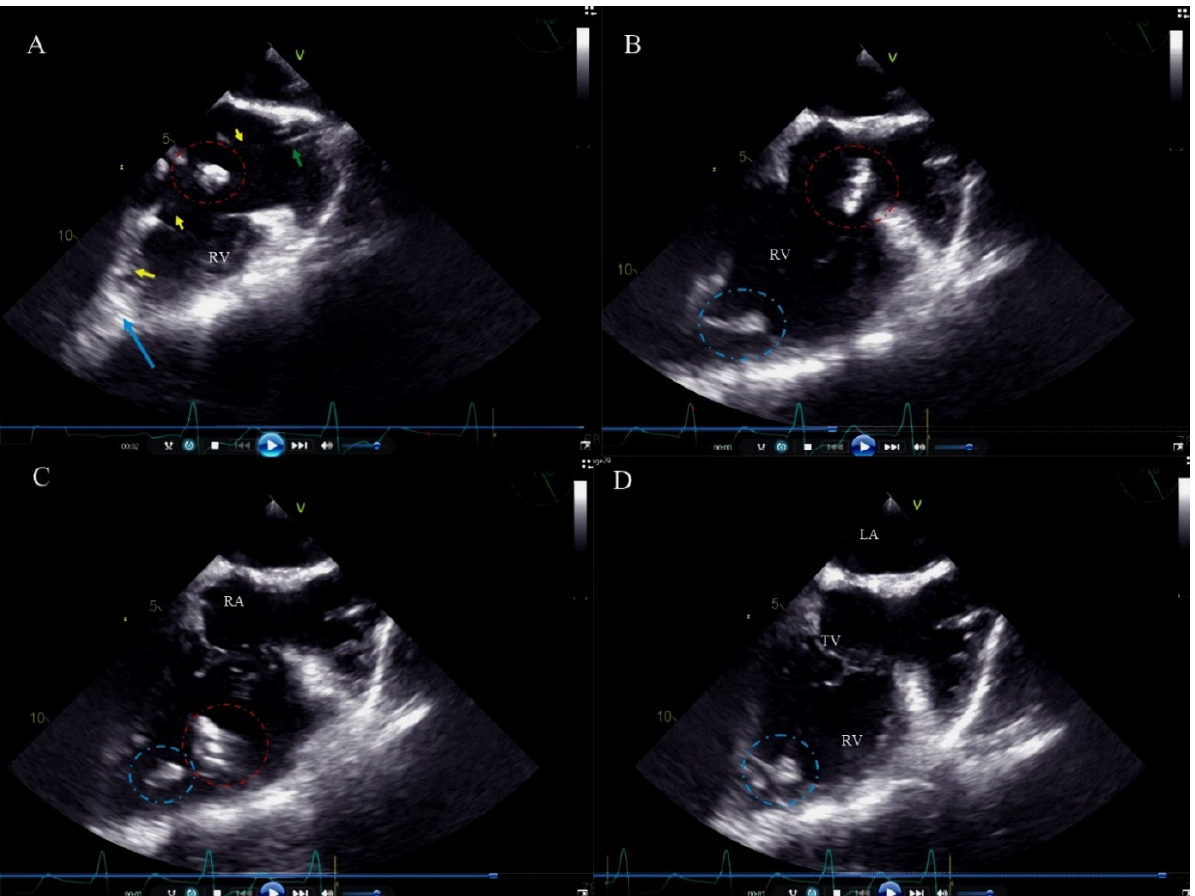
Figure 3. Concomitant occurrence of FG and SG and their fate imaged by 2D TEE (the sequences of the video and the behavior of the ghosts are represented “frame by frame”). ( A ) Ventricular lead (yellow arrows) dissected using the Byrd dilator sheath (green arrow). Scar tissue pushed in front of the catheter (red circle). The end piece of the lead adhered to the RA endocardium (blue arrow). ( B ) After lead extraction FG (red circle) in the RA and SG (blue circle) in the RV. ( C ) FG travelled in the bloodstream to the RV in the next heartbeat, whereas SG remained in the RA. ( D ) In the subsequent cardiac cycles FG „disappeared” in the pulmonary circulation, only SG remained in place.